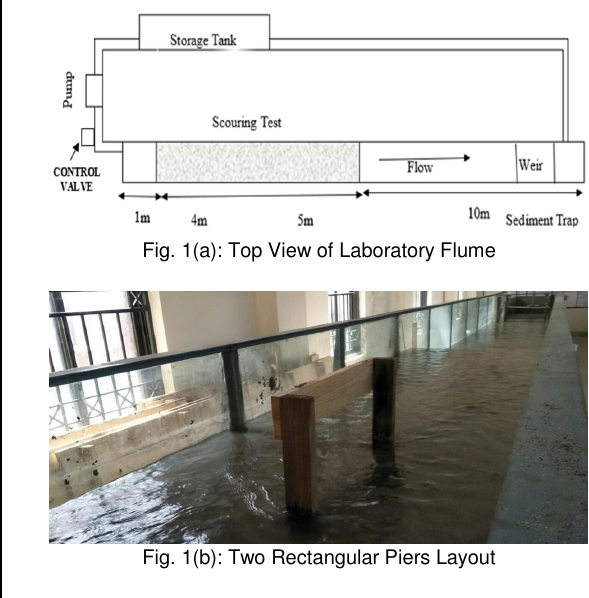
Fig. 1(b): Two Rectangular Piers Layout